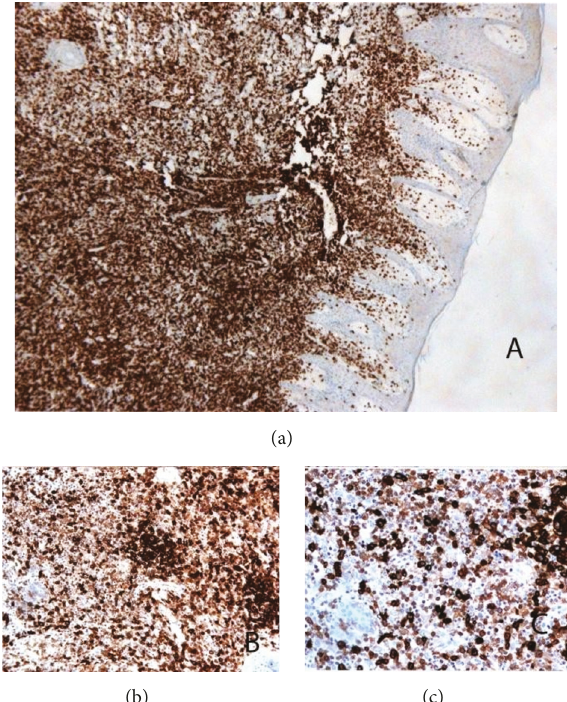
Figure 3: Immunophenotypically the lymphocytes were CD3+ (x20) (a) and > 75% CD30+ (x40) (b) and (x60) (c) (Immunohistochemistry with Envision Detection System Peroxidase/DAB,